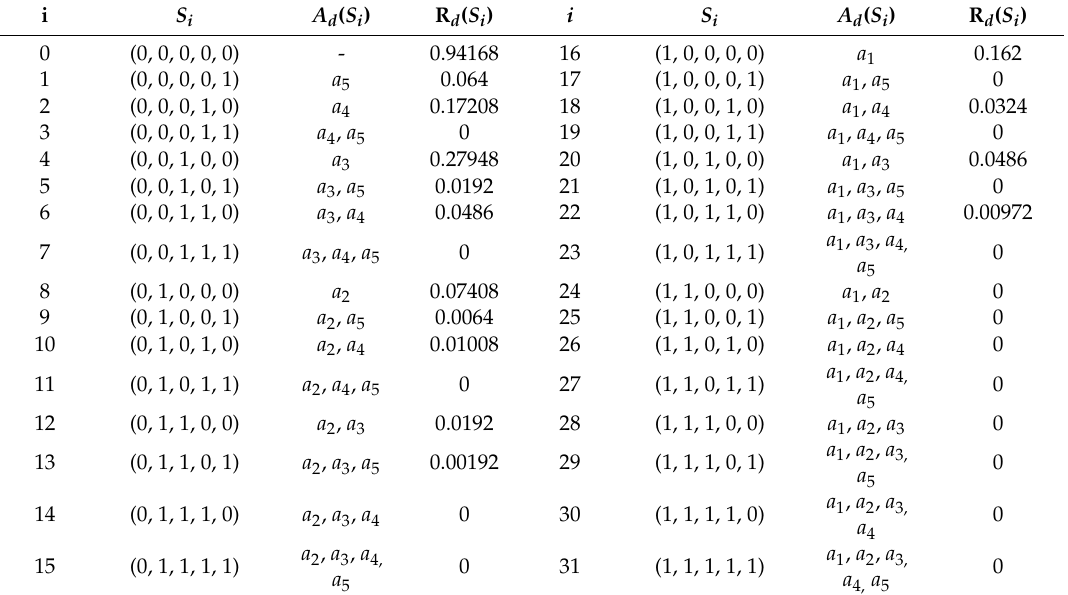
Table 2. All the S i from Figure 2.